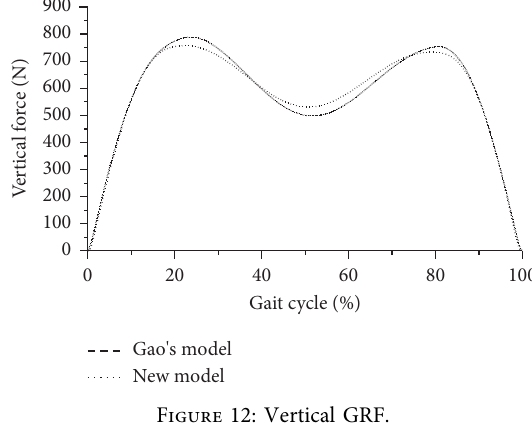
Figure 12: Vertical GRF.